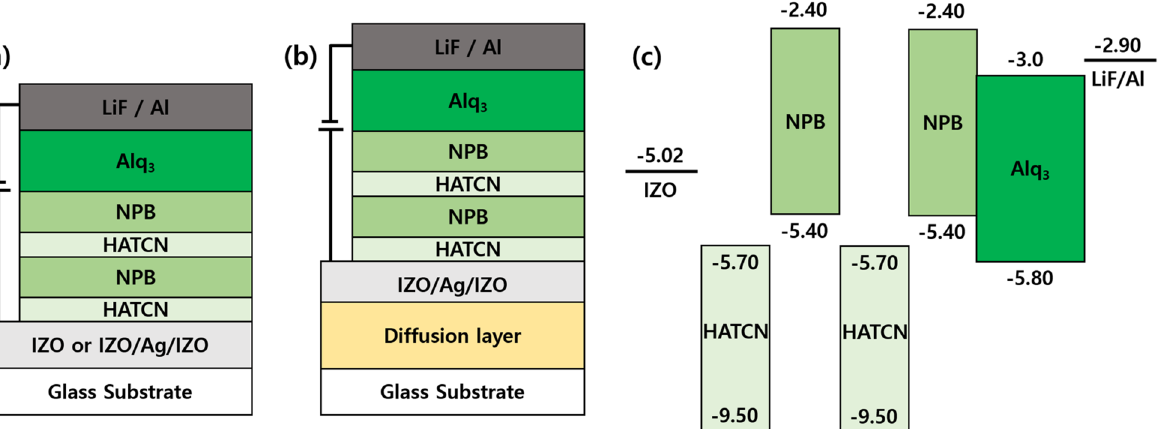
Figure 4. Schematic of the structure of the OLEDs ( a ) without a diffusion layer (both Non-cavity and Micro-cavity devices, and ( b ) MC-OLEDs with a diffusion layer (Device A and B, fabricated under different conditions); ( c ) energy band diagram of materials for